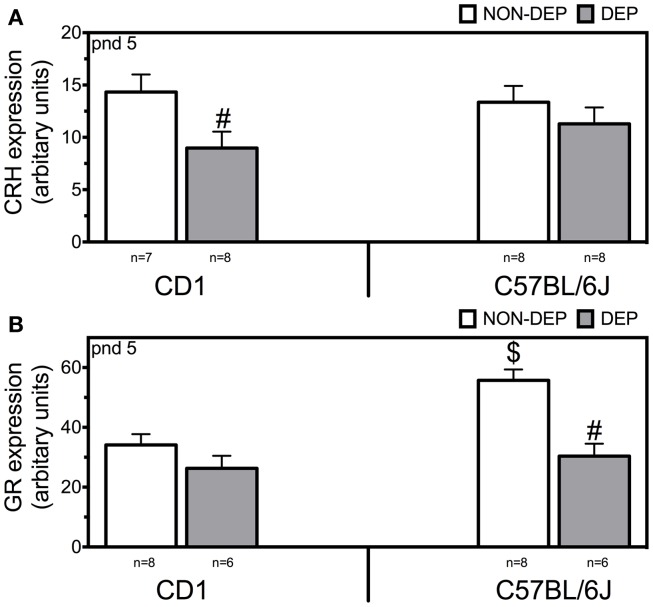
CRH (A) and GR (B) mRNA expression in the paraventricular nucleus of the hypothalamus measured in non-deprived (NON-DEP) and deprived (DEP) mice at postnatal day (pnd) 5. Data represent mean ± SEM. # vs. NON-DEP, $ vs. CD1. Significance level was set atp = 0.05.